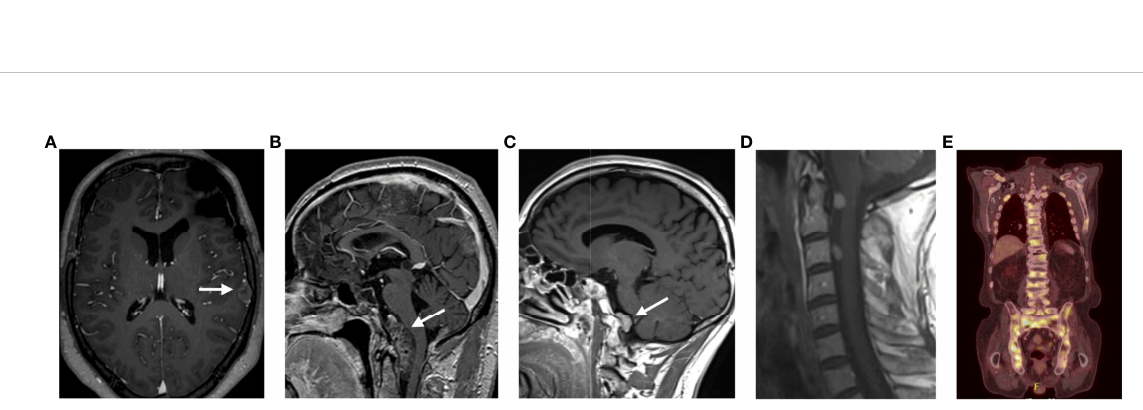
FIGURE 3 Representation of the different locations of the metastatic lesions of all patients. (A) Patient 2; (B) Patient 1; (C) Patient 3; (D) Patient 5; (E) Patient